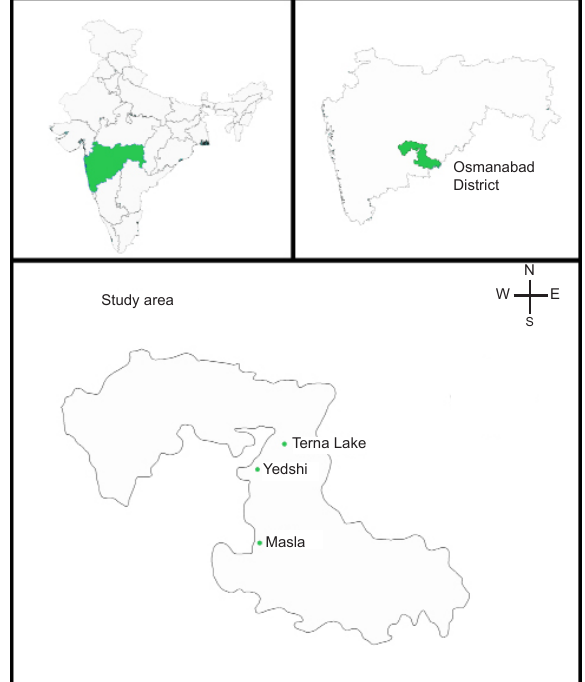
Figure 1. Study area